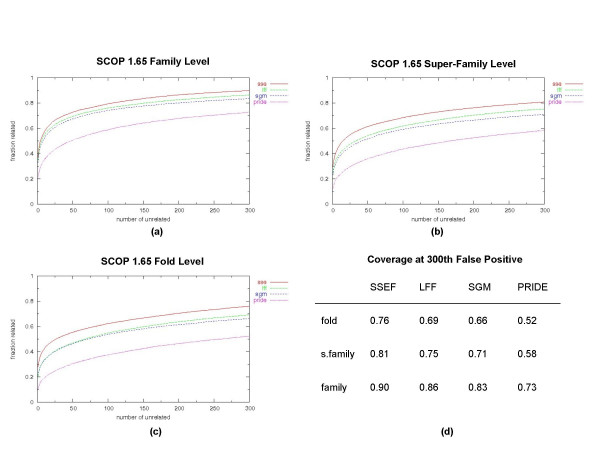
Coverage versus error plots. Coverage versus Error plots for the SSEF, LFF, SGM, and PRIDE2 methods. Given a projection method and a database of protein domains, each query protein domain defines a curve, which plots coverage (the fraction of related protein domains retrieved) against the number of errors (the number of unrelated domains retrieved). To obtain one curve per projection method the individual curves were averaged, first across different queries in the same classification group and then across different classification groups (see Methods). (a) Pairs in the same SCOP family are true positives; pairs in different SCOP families are false positives. (b) Pairs in the same SCOP super-family are true positives; pairs in different SCOP super-families are false positives. (c) Pairs in the same SCOP fold are true positives; pairs in different SCOP folds are false positives. (d) Coverage obtained by projection methods at different classification levels when 300th false positive result is encountered.